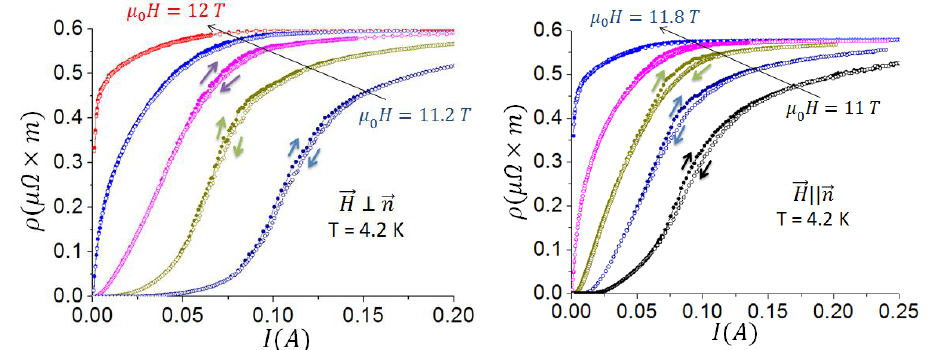
Fig. 5. A series of RCCs for the heat-treated Nb-Ti tape. The external magnetic field is perpendicular to rolling and lies in the plane of the tape. The value of the magnetic field varies in the range from 11.2 T to 12 T in steps of 0.2 T. Upper critical field for this geometry is μ 0 H c2 =11.9 T [3].